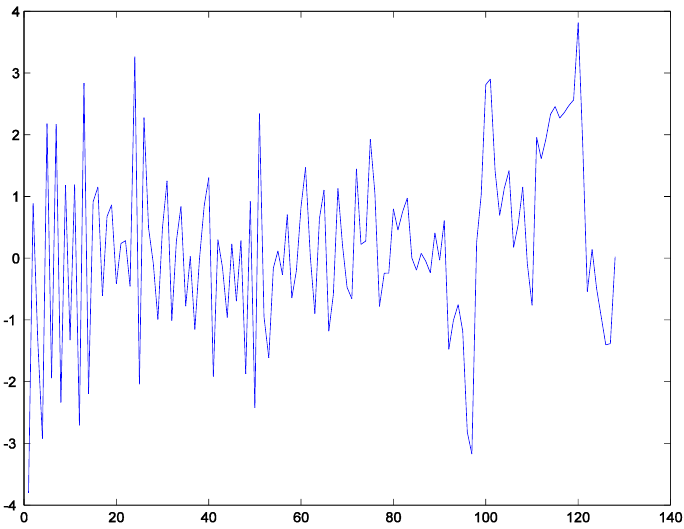
Figure 2. Artificial series produced using the process defined by (1) and (13) (see the text for details).